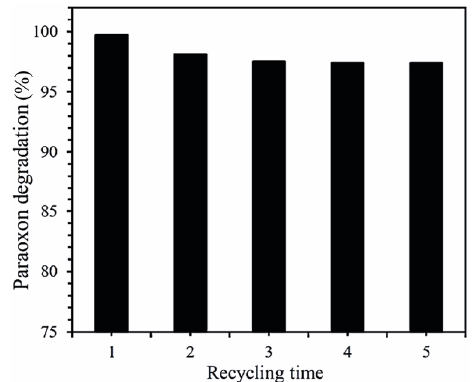
Fig. 9 Reusability of the NTiO 2 -G thin film for visible light degradation of